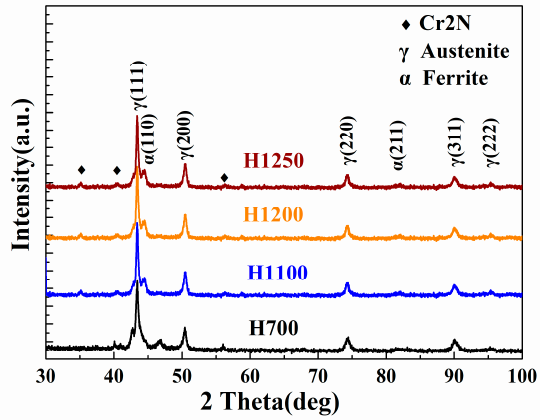
Figure 4. XRD patterns of porous HNASSs reduced by H 2